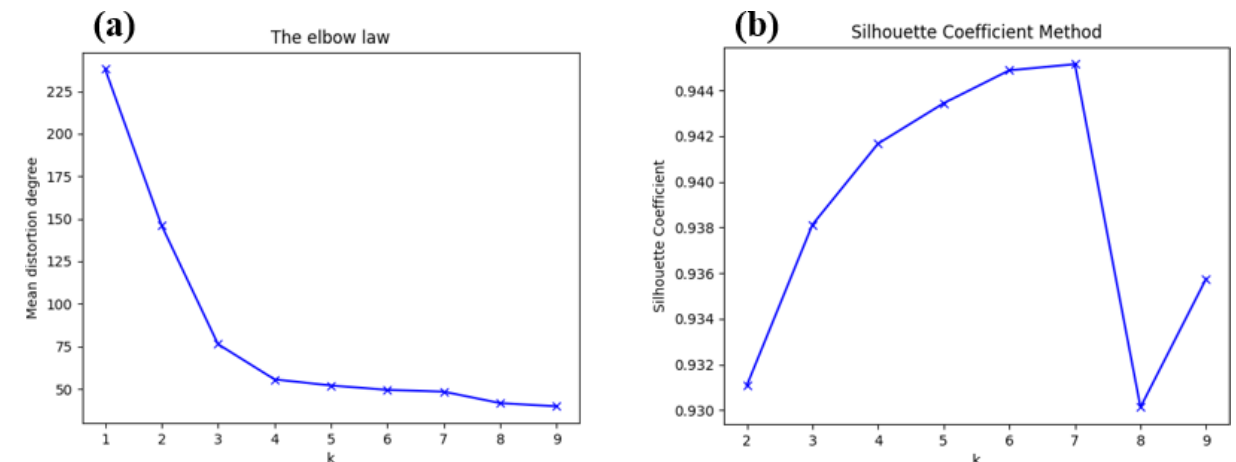
Figure 2. Evaluation for different number of categories using k -means analysis by the elbow law and silhouette coefficient method.